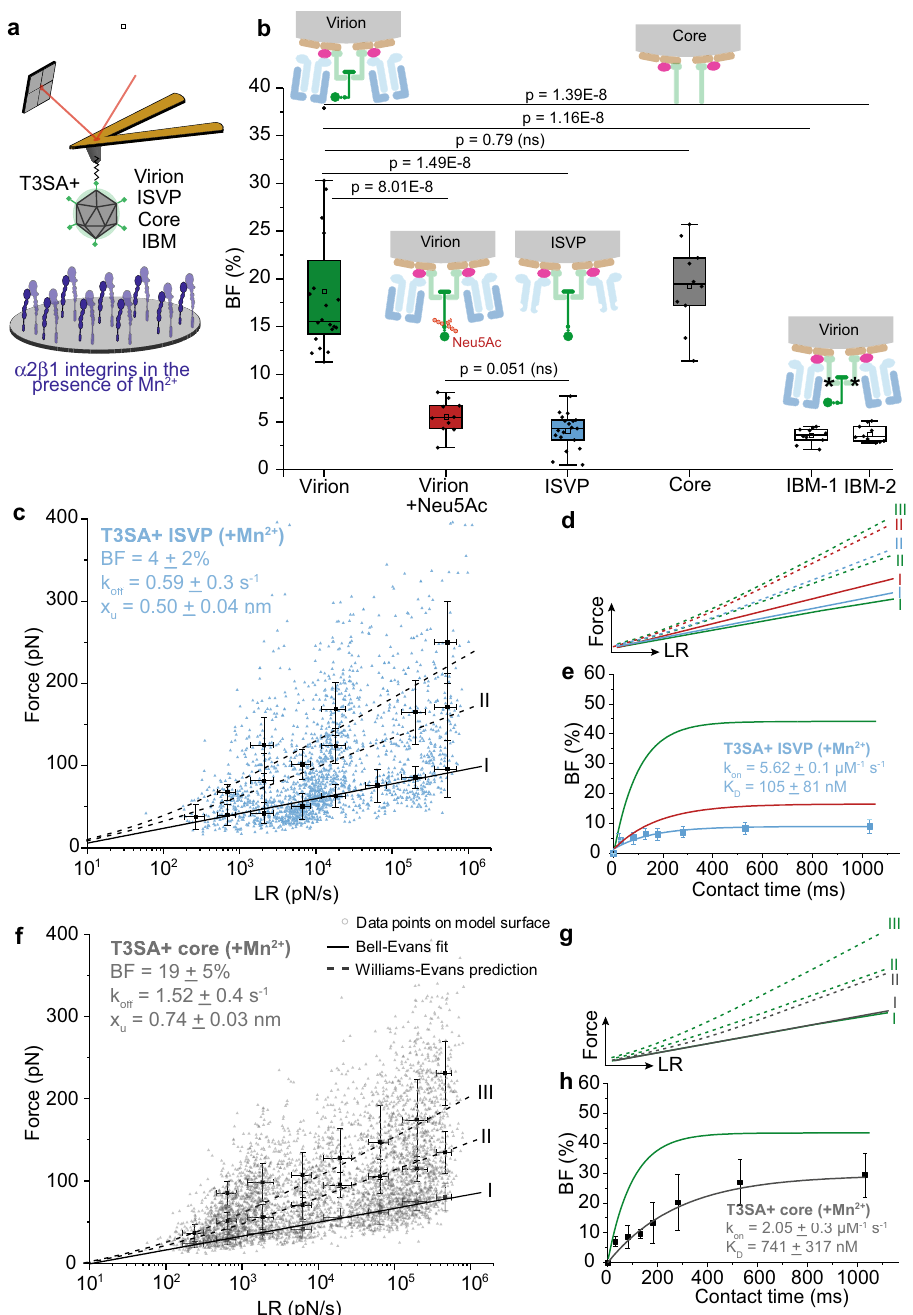
Fig. 5 Analysis of β 1 integrin interactions with reovirus disassembly intermediates suggests λ 2 as the viral integrin ligand. a Schematic depicts the experimental set up. All experiments were conducted in the presence of Mn 2 + . b Box plot of BF between β 1 integrins and T3SA + virions, ISVPs, cores, or IBM-1/-2 (integrin binding motif mutant) quanti fi ed using AFM under the conditions shown. The horizontal line within the box indicates the median, boundaries of the box indicate the 25th and 75th percentile, and whiskers indicate the highest and lowest values. An open square within each box indicates the mean. c – e Binding of T3SA + ISVPs to β 1 integrins (colored in blue) in comparison with virions before (colored in green) and after (colored in red) incubation with Neu5Ac. c DFS plot of the interaction forces between integrins and T3SA + ISVPs show that ISVPs display a different kinetic bond rupture behavior compared with T3SA + virions in the absence of Neu5Ac but the same behavior as T3SA + virions in the presence of Neu5Ac (as shown in d ). e k on and K D determined from measuring BF as a function of contact time indicates that the af fi nity of ISVPs for integrin is comparable to that of virions in the presence of Neu5Ac. f – h Binding of T3SA + cores (colored in gray) to β 1 integrins differs from that of T3SA + virions (colored in green). Plots display DFS data ( f ), comparison of T3SA + cores (gray) with virions (green) ( g ), and kinetic on-rate measurements ( h ). Control experiments are shown in Supplementary Fig. 5. Error bars indicate s.d. of the mean. All data are representative of N = 3 independent experiments. Ten AFM tips were analyzed per condition. P values were determined by two-sample t -test using Origin